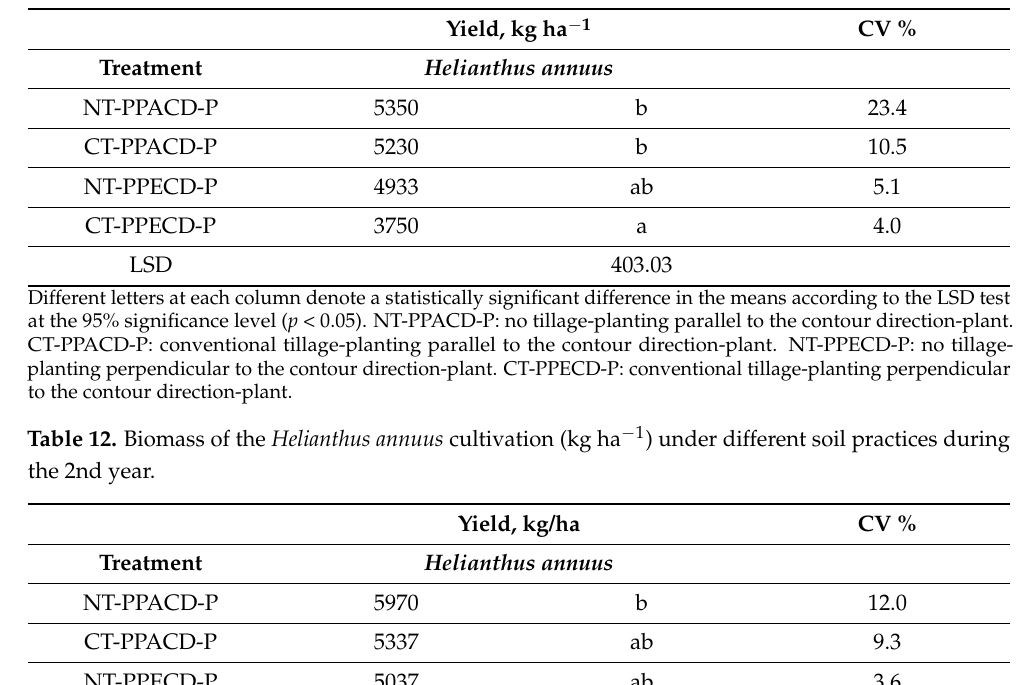
Table 11. Biomass of the Helianthus annuus cultivation (kg ha − 1 ) under different soil practices during the 1st year.